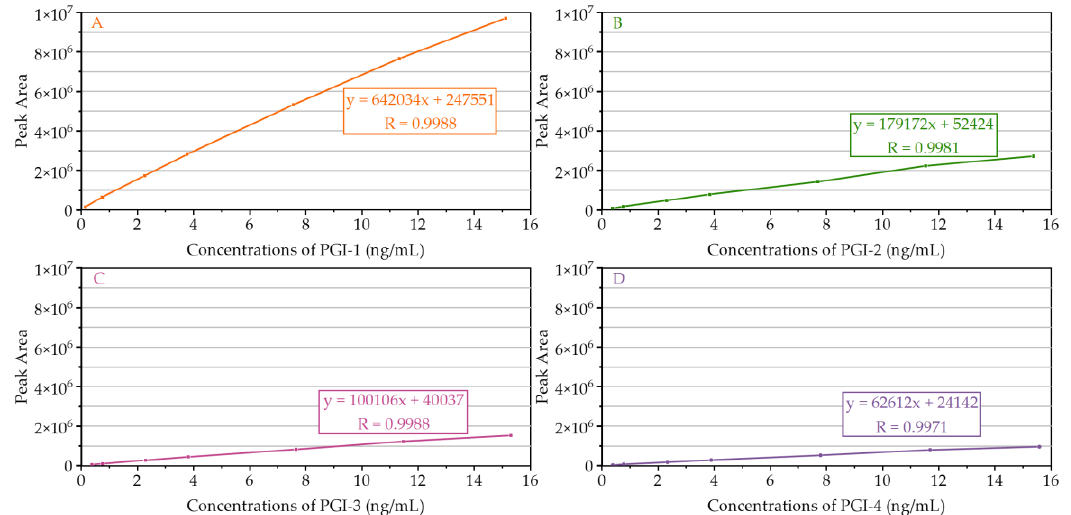
Figure 4. Calibration curves for the determination of ( A ) PGI-1, ( B ) PGI-2, ( C ) PGI-3, and ( D ) PGI-4 of seven levels of standard solutions. Table 1. LOD, LOQ, and linear regression equation of PGI-1, PGI-2, PGI-3, and PGI-4.